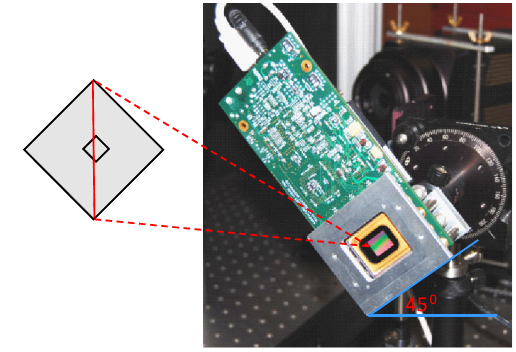
FIG. 2. Picture of rotated DMD (Discovery 1100) and an enlarged sketch of a